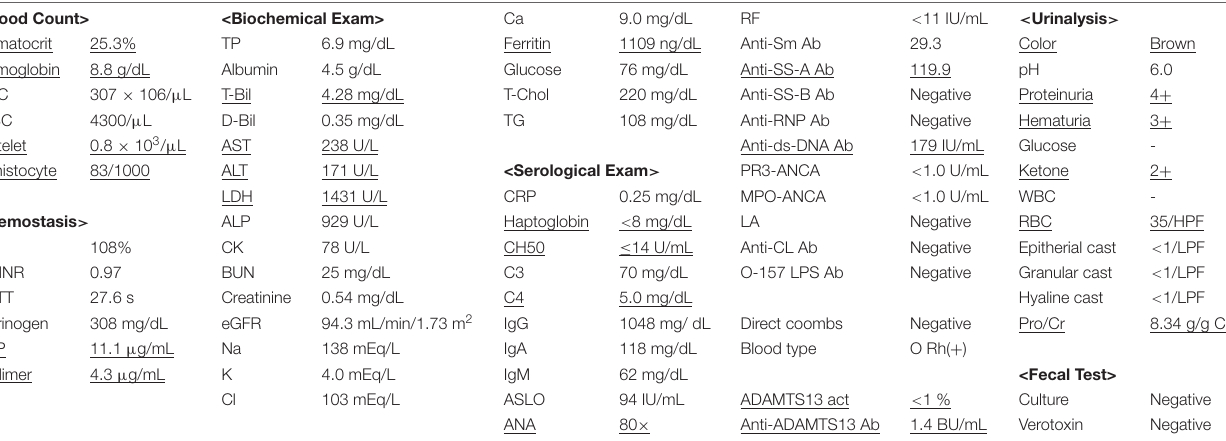
TABLE 1 | Laboratory findings on